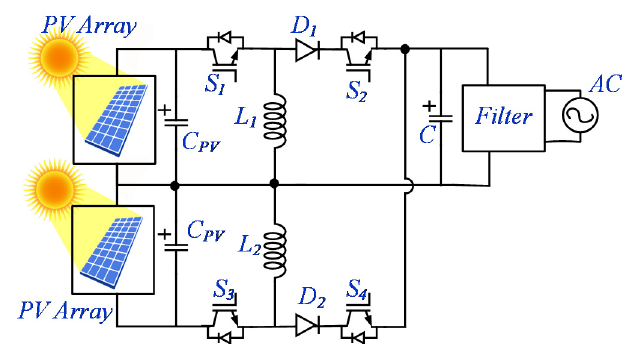
Figure 18. Two-sourced anti-parallel buck-boost inverter.